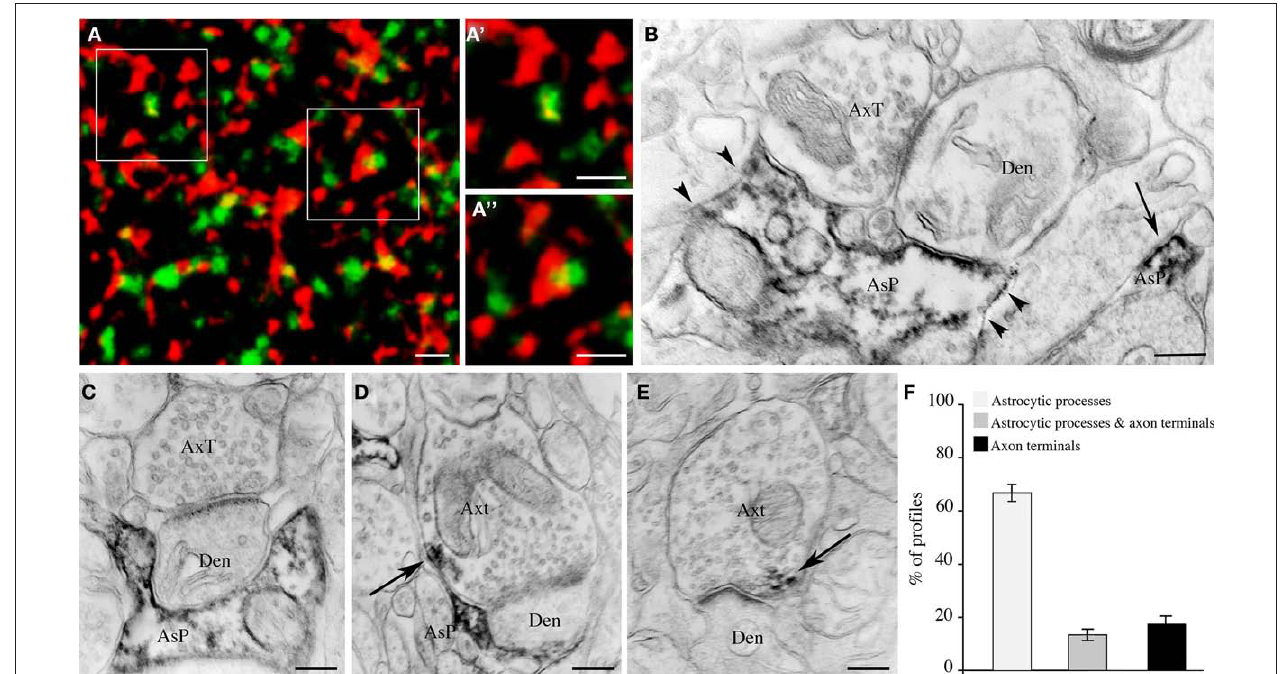
EAAT2a localization to (1) astrocytic processes in intimate association with asymmetric synapses whose axon terminal is not EAAT2a-ir (C) ; (2) astrocytic processes in close association with EAAT2a + axon terminals forming asymmetric synapses [arrow in (F) ]; and (3) axon terminals making asymmetric synapses [arrow in (E) ]. Area 8, HBC 030129. (F) Proportion of the different organizational models. Den, dendrite; AsP astrocytic process; AxT, axon terminals. Scale bars: 1 μm for (A–A ″ ) ; 0.25 μm for (B–E)